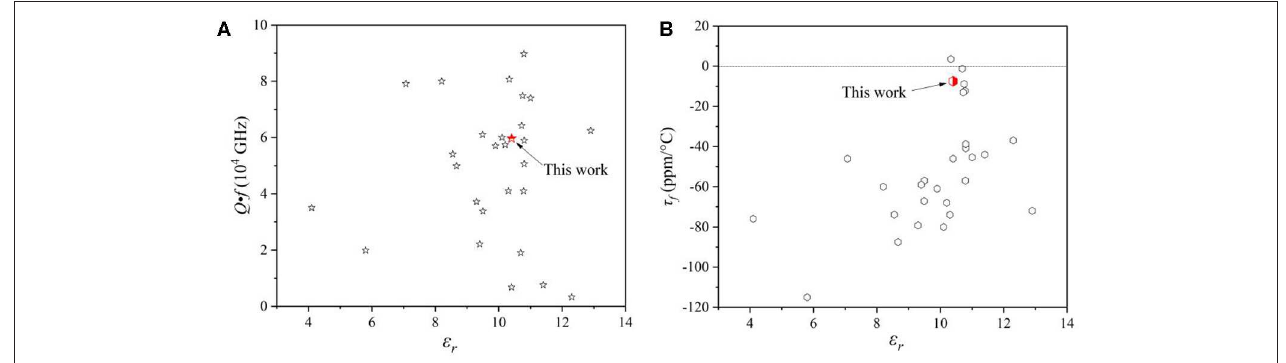
f ) and (B) the temperature coefficient of resonant frequency ( τ f ) of Mo-based microwave dielectric ceramics with a low dielectric FIGURE 7 | (A) Quality factors ( Q · constant.